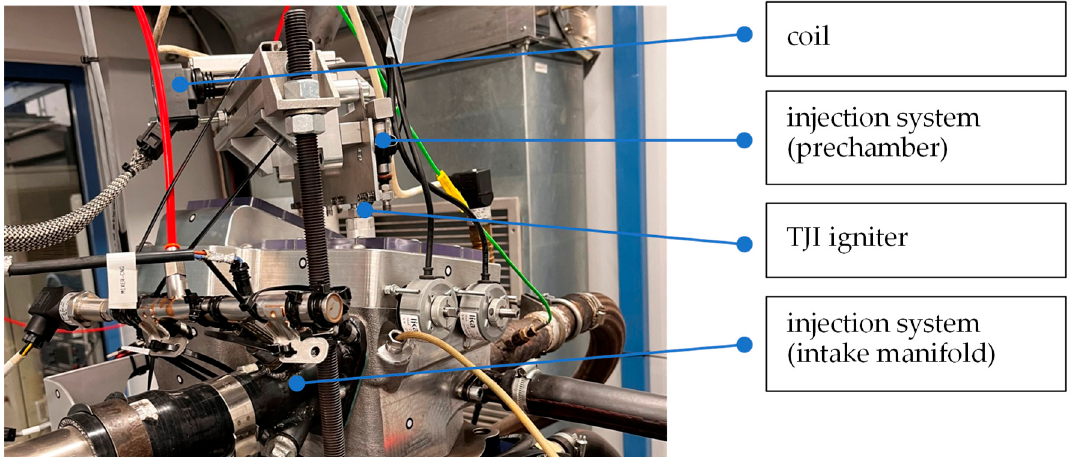
Figure 4. Image of two gas supply systems: (1) to the prechamber and (2) to the intake duct. The combustion chamber was equipped with a prechamber with a volume of 2.29 cm 3 .